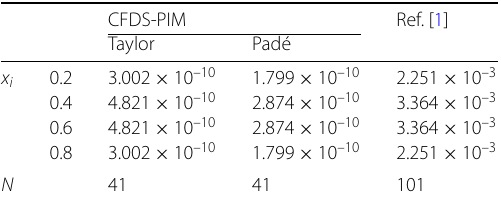
Table 2 The error comparison between CFDS-PIM and the other method at t = 2. N is the number of points of the one-dimensional mesh in case 1 of Example 1 CFDS-PIM Ref. [1] Taylor Padé x i